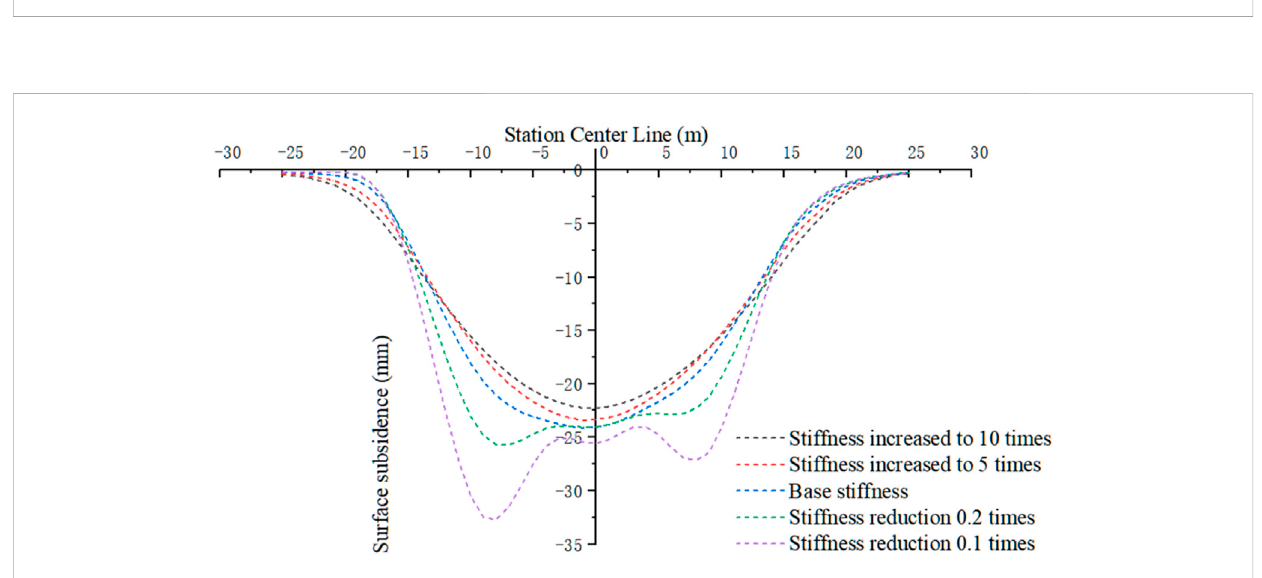
FIGURE 20 De fl ection curve of pipe roof under different steel pipe stiffness.